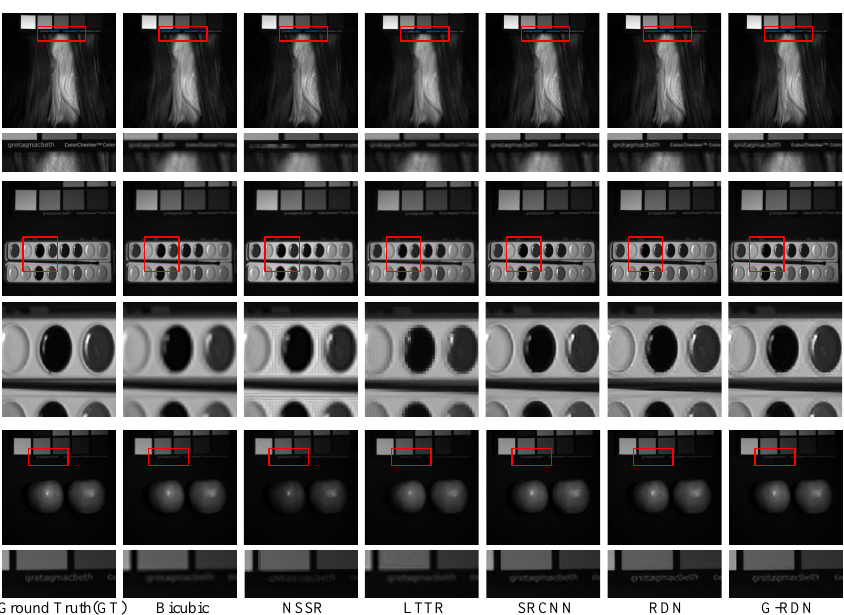
Figure 7. Visual exhibition of the reconstructed test HSIs for the CAVE dataset at the scaling factor of